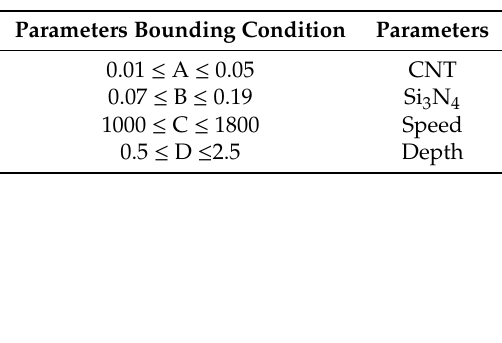
Table 3. Boundary conditions used for implementing particle swarm optimization (PSO) and firefly algorithm (FFA)